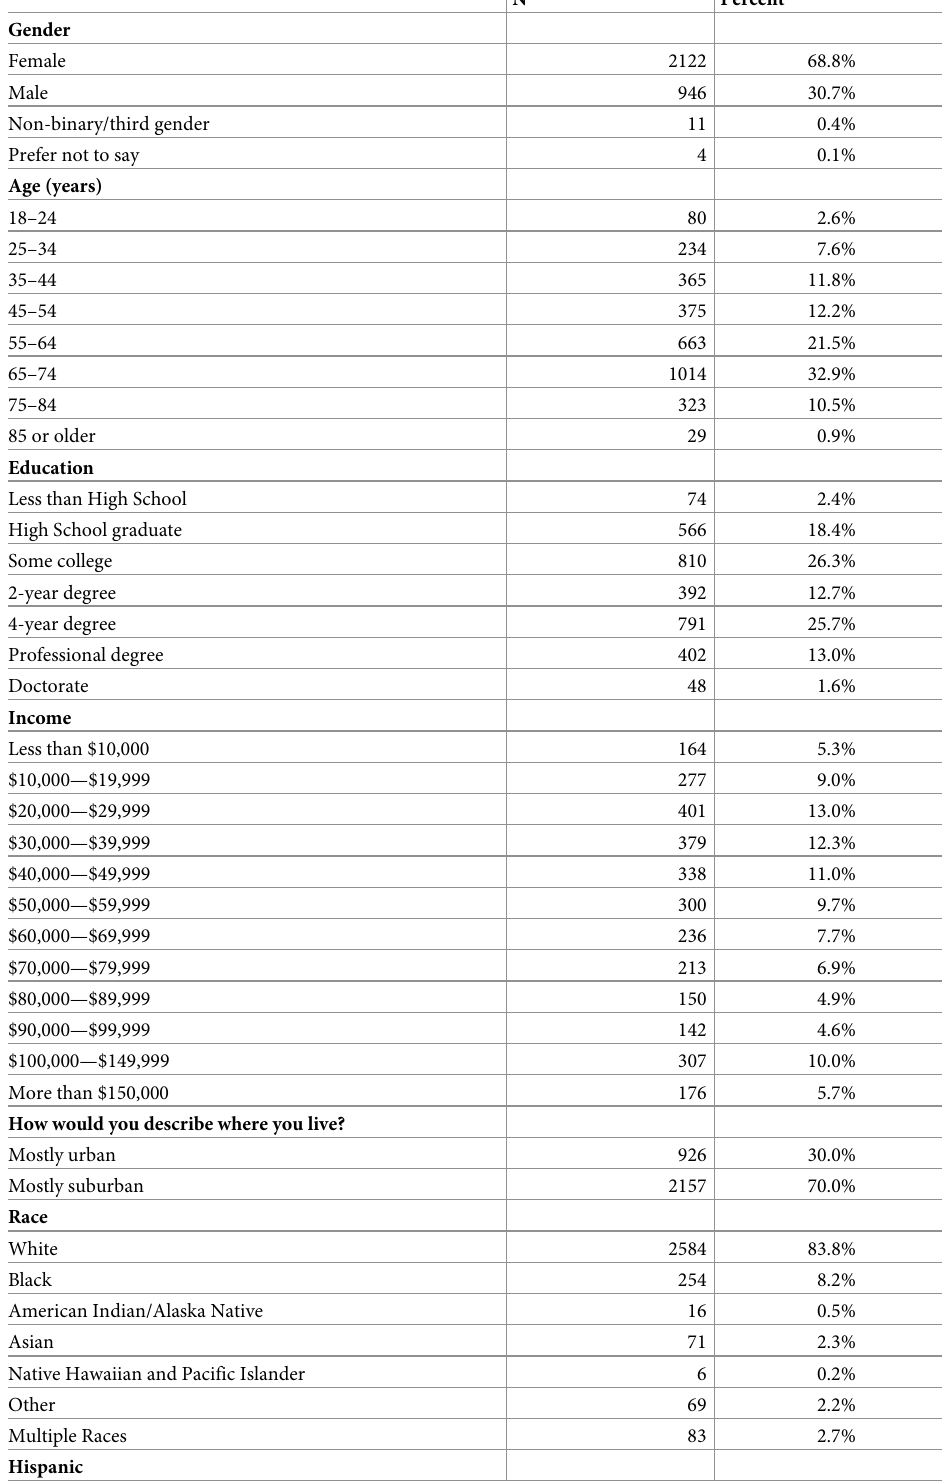
Table 1. Demographic characteristics of